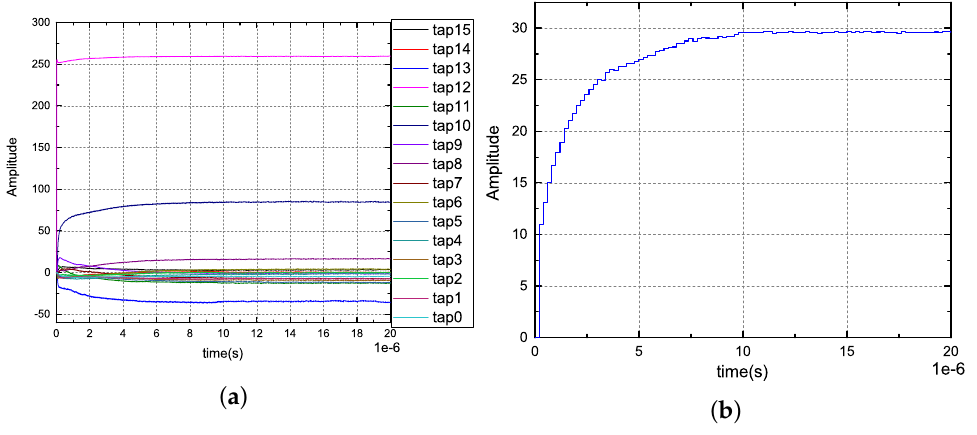
Figure 12. ( a ) FFE coefficients. ( b ) DFE